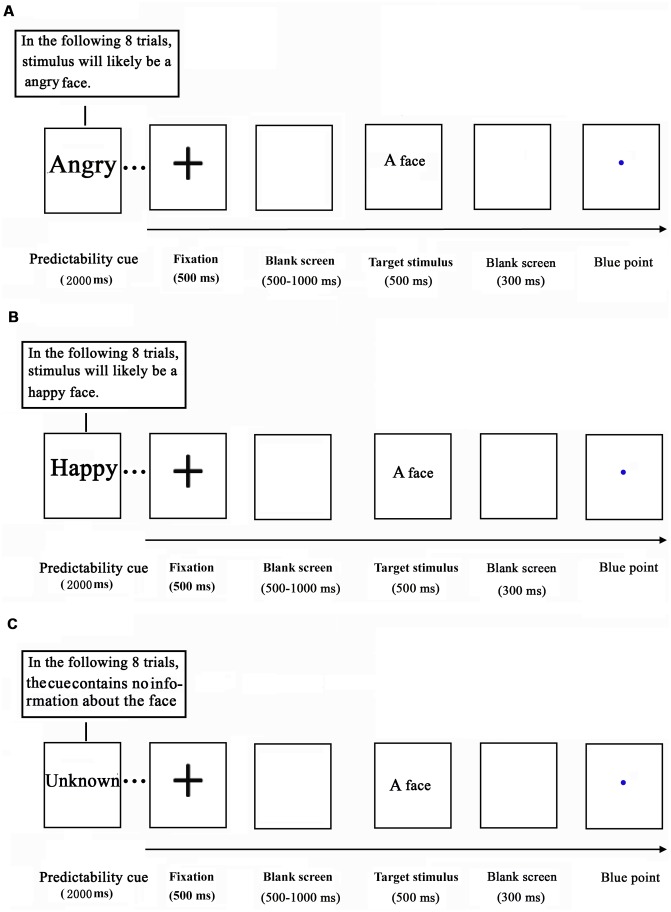
Schematic illustration of the experimental procedure (A: angry predictable trials; B: happy predictable trials; C: Unpredictable trials).